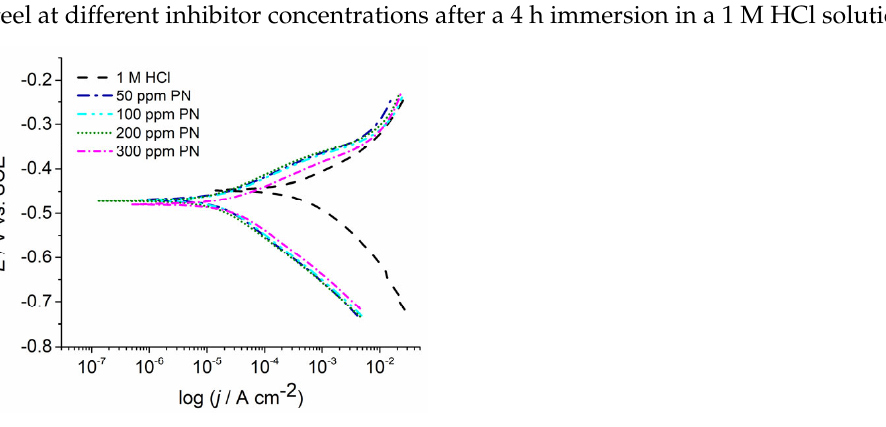
Figure 6. Carbon steel polarization curves in 1 M HCl containing different concentrations of PN inhibitor after 4 h immersion.